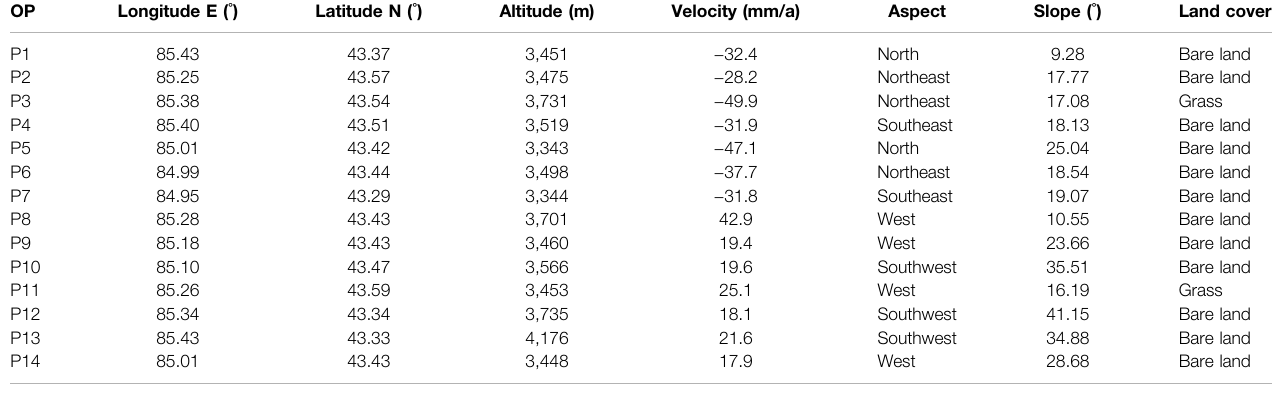
TABLE 3 | Basic information for the observation points. OP Longitude E ( ° )